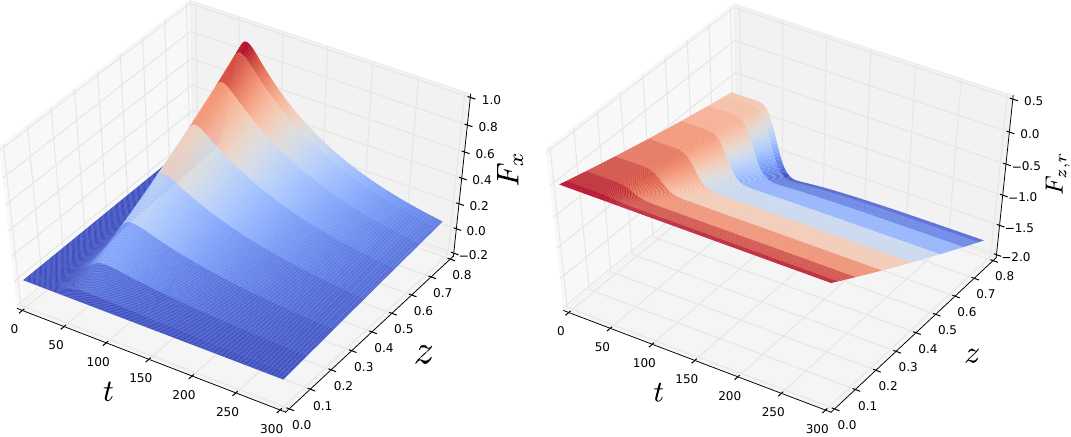
Figure 3 . Plots of bulk pro(cid:12)le of the metric functions F z;r and F x interpolating between initial and (cid:12)nal equilibrium state. The parameters corresponding to the plot are: (cid:22) I = 1 ; T I = 0 : 2 ; T F = 0 : 3 ; k = 0 : 2 ; ! P = 0.